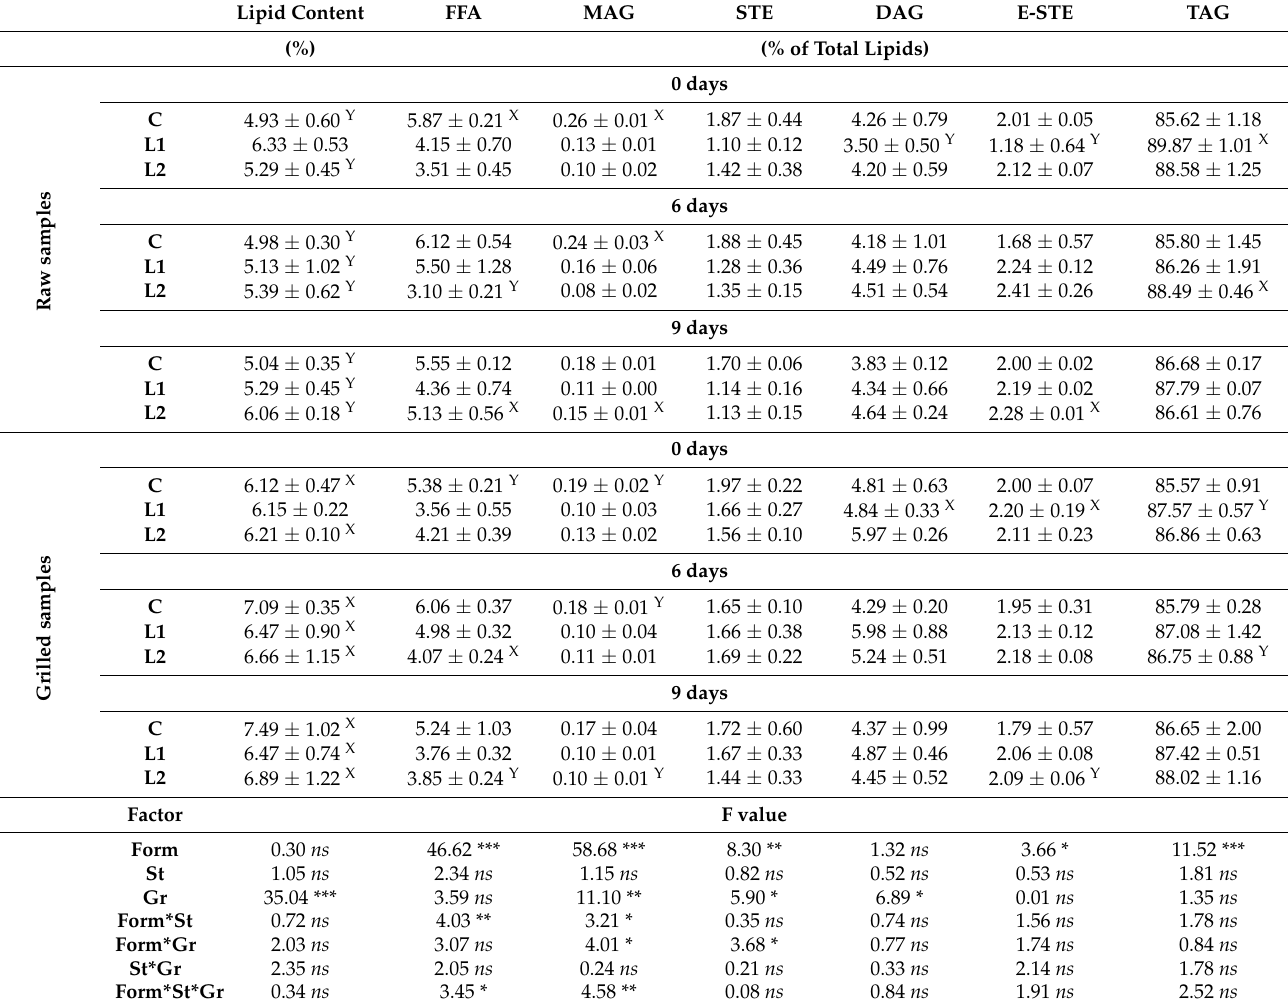
Table 3. Lipid content and main lipid classes profile of raw and grilled hamburger samples after 0, 6 and 9 days of storage. C, Control (minced beef meat + maltodextrine + starter cultures); L1, minced beef meat + starter cultures + 87.5 mg phenols/kg of meat; L2, minced beef meat + starter cultures + 175 mg phenols/kg of